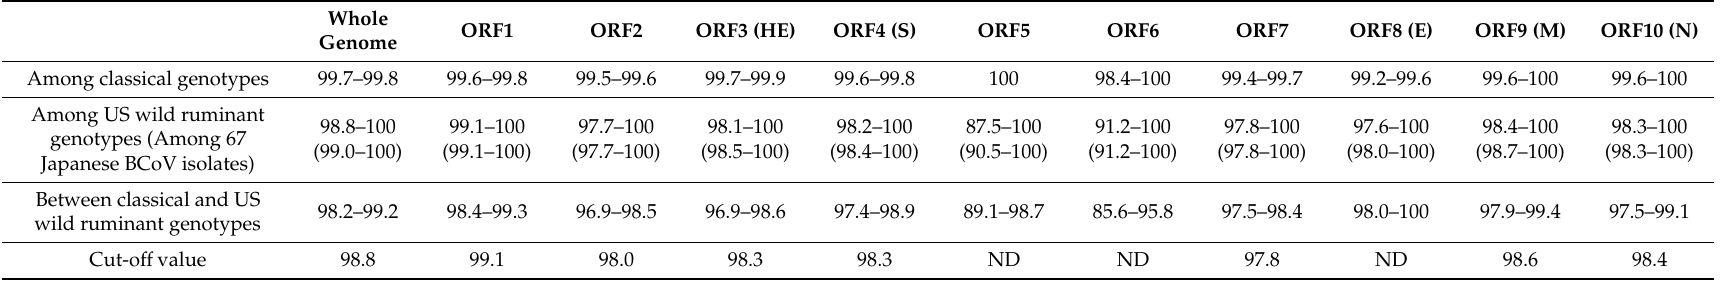
Table 1. Sequence identities (%) of whole genomes and individual open reading frames among classical genotypes from 3 BCoV strains (Quebec, Mebus, and Kakegawa), and US wild ruminant genotypes from the 80 remaining BCoV strains including 67 Japanese BCoV isolates, and between classical and US wild ruminant genotypes at nucleotide